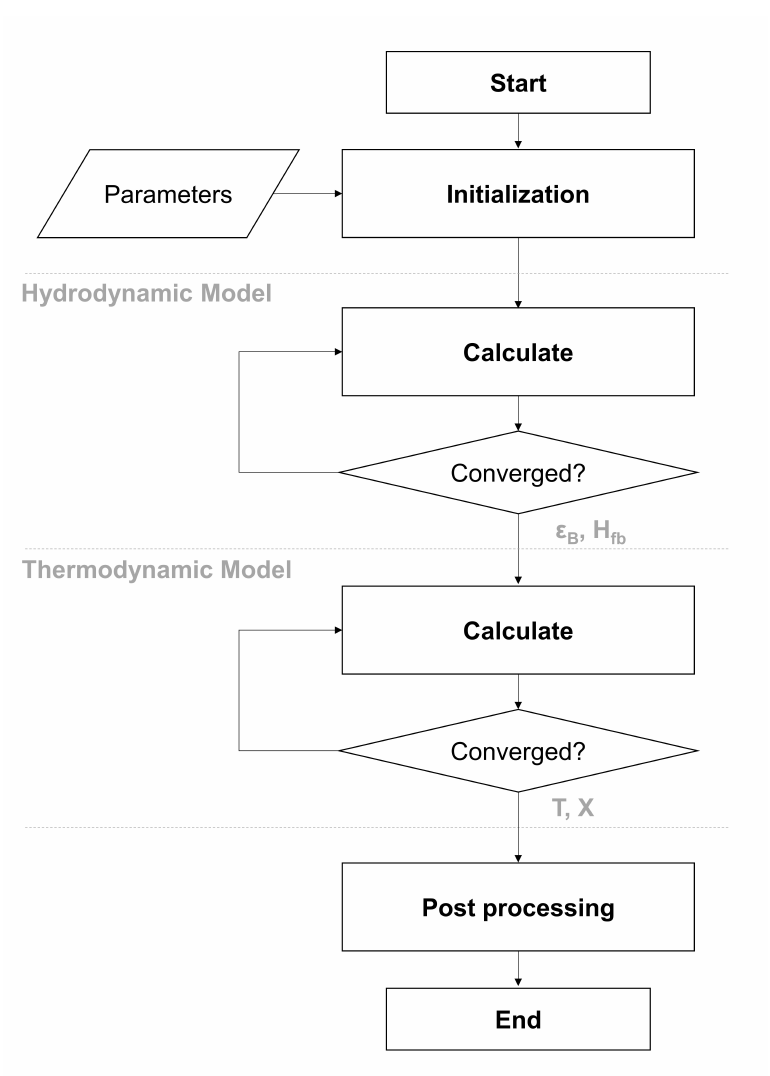
Figure 2. Schematic flowchart of the algorithm of the vibrated fluidized bed drying model, imple- mented in